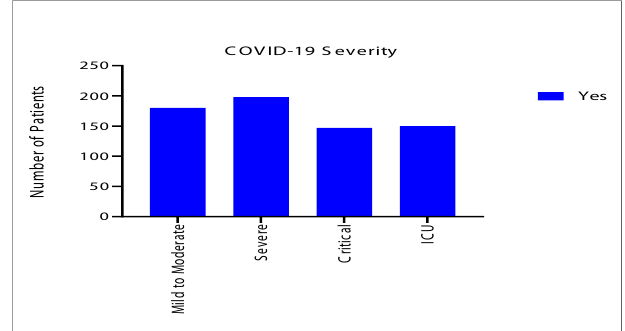
FIGURE 4 | Clinical severity of the 525 symptomatic COVID-19 patients.